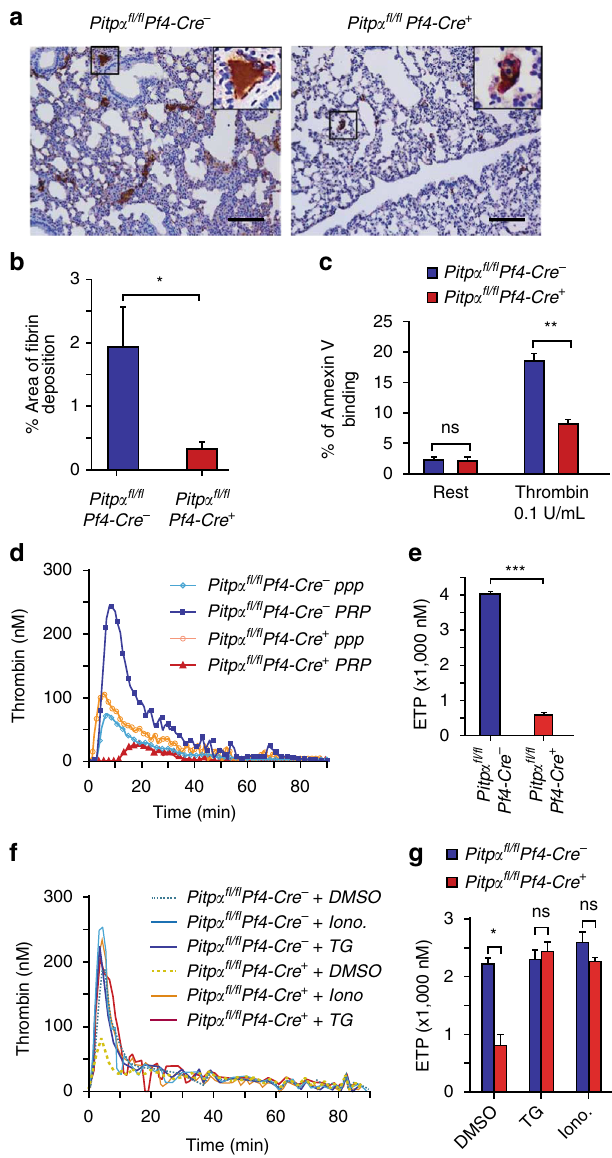
Fig. 4 Loss of PITP α in platelets impairs fi brin deposition and thrombin generation. a Immunohistochemistry staining for fi brin in tumor-induced thrombi found in lung tissue at 3 h after tumor injection. The brown color indicates fi brin deposition within the tissue. Black scale bars represent 100 µ m. b Quanti fi cation of fi brin deposition based on immunohistochemistry staining. N = 3 mice per group. * p < 0.05, unpaired Student ’ s t -test. Error bars are s.d. c Platelets lacking PITP α have an impaired ability to bind Annexin V ex vivo. The mean values are averaged from four independent experiments. ** p = 0.001, unpaired Student ’ s t -test. Error bars are s.d. d Ex vivo TGA initiated by B16F10 tumor cells. Shown is representative kinetics of thrombin generation in PRP and in PPP. e The endogenous thrombin potential (ETP) shown is the mean value of total thrombin generated in PRP, containing either PITP α wild-type platelets (blue bar) or PITP α -null platelets (red bar). N = 3 mice per group. *** p = 0.01, unpaired Student ’ s t -test. Error bars are s.d. f , g Thrombin generation initiated by B16F10 tumor cells in the presence of agonist TG and calcium ionophore (Iono.). N = 3 mice per group. * p < 0.05, unpaired Student ’ s t -test. Error bars are